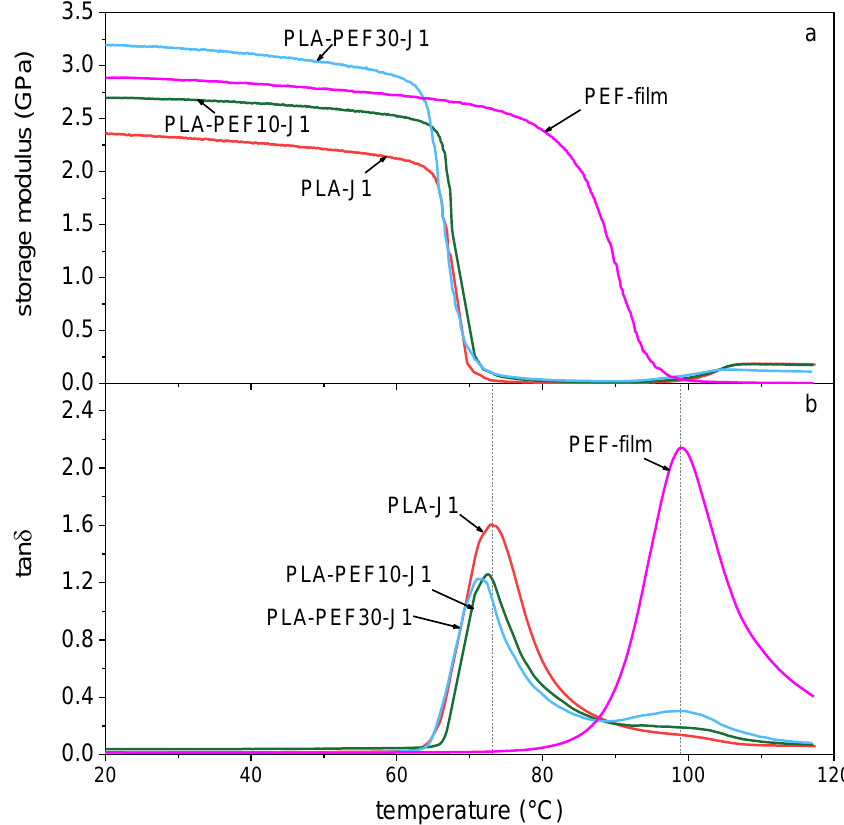
Figure 7. Representative DMTA thermograms of some selected compositions. ( a ) Storage modulus as a function of temperature; ( b ) tan δ (smoothed) as a function of temperature. Dashed vertical lines evidence the tan δ peak temperatures of PLA (73.2 ◦ C) and PEF (98.8 ◦ C).